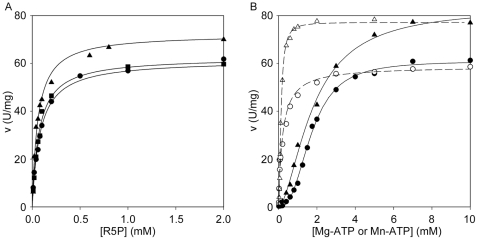
Steady state kinetics of MtbPRPPase.(A) Steady state kinetics of MtbPRPPase as a function of R5P. All assays were performed at fixed 10 mM Mg-ATP, in the absence of free divalent ions (•), in the presence of 5 mM MgCl2 (▪), and in the presence of 5 mM MnCl2 (▴). (B) Steady state kinetics of MtbPRPPase as a function of Mg-ATP. All experiments were performed at fixed 2 mM R5P, in the absence (•) and in the presence (○) of 5 mM MgCl2, and as a function of Mn-ATP in the absence (▴) and in the presence (▵) of 5 mM MnCl2. Enzyme assay conditions are reported in the “Material and Methods” section.